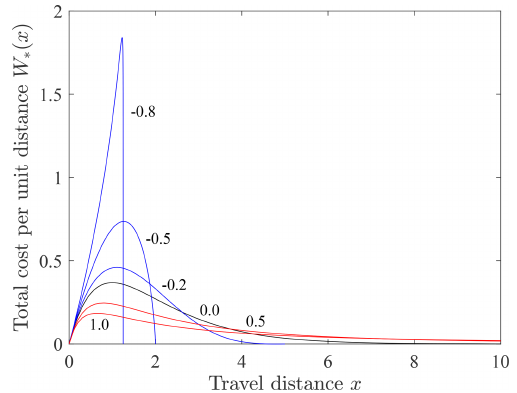
Figure 7. Plot of the total cost per unit travel distance W ∗ ( x ) versus travel distance x for different values of the shape parameter A rep- resenting net cooling ( A < 0, blue), isothermal conditions ( A = 0, black) and net heating ( A > 0,